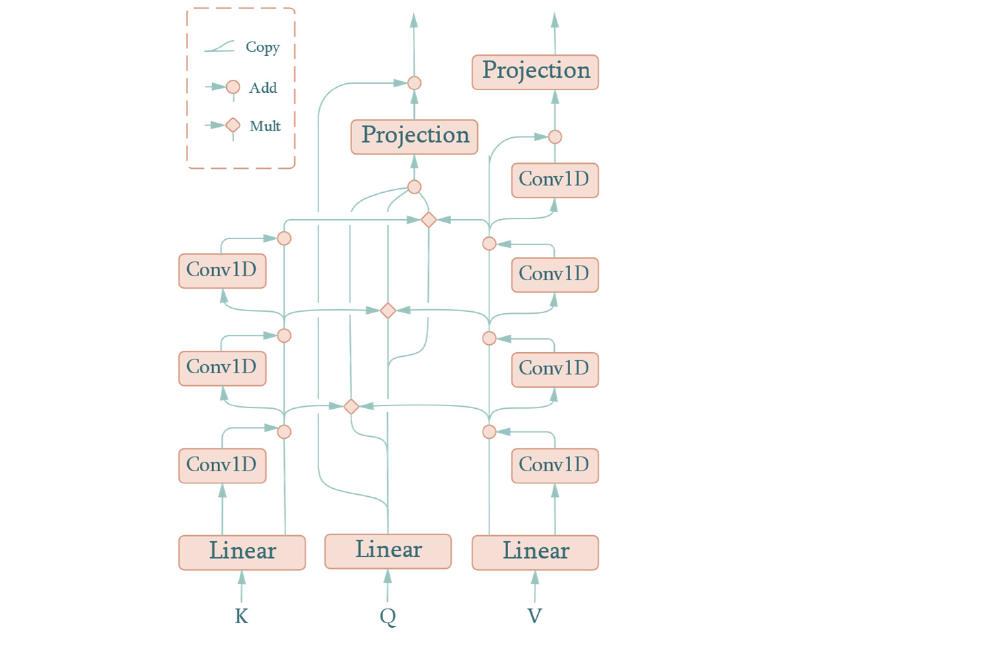
Figure 4. AMAM structure.